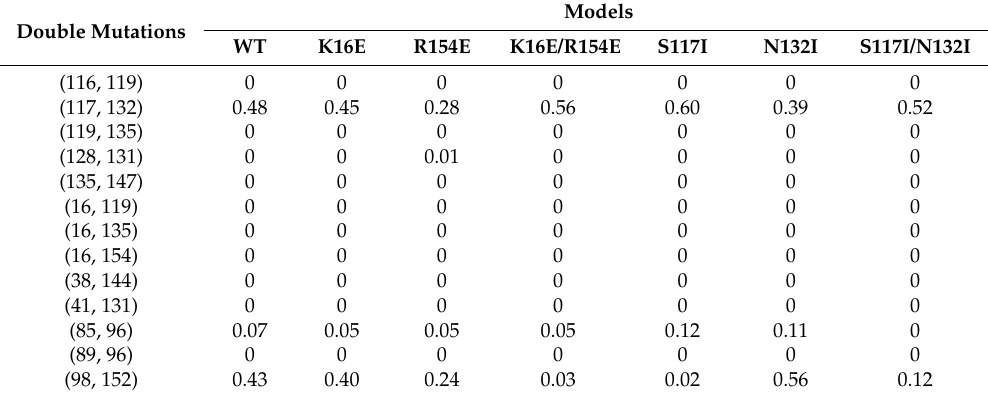
Table 2. P ab for double-site mutations derived from the different T4 phage lysozyme models. WT stands for wild type lysozyme structure (PDB code 2LZM [14]), K16E for the mutant structure (PDB code